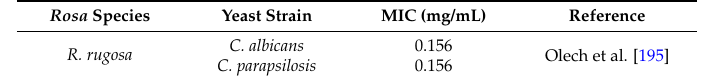
Table 7. Anti-mycotic effect of some Rosa species displayed as minimal inhibitory concentration (MIC).